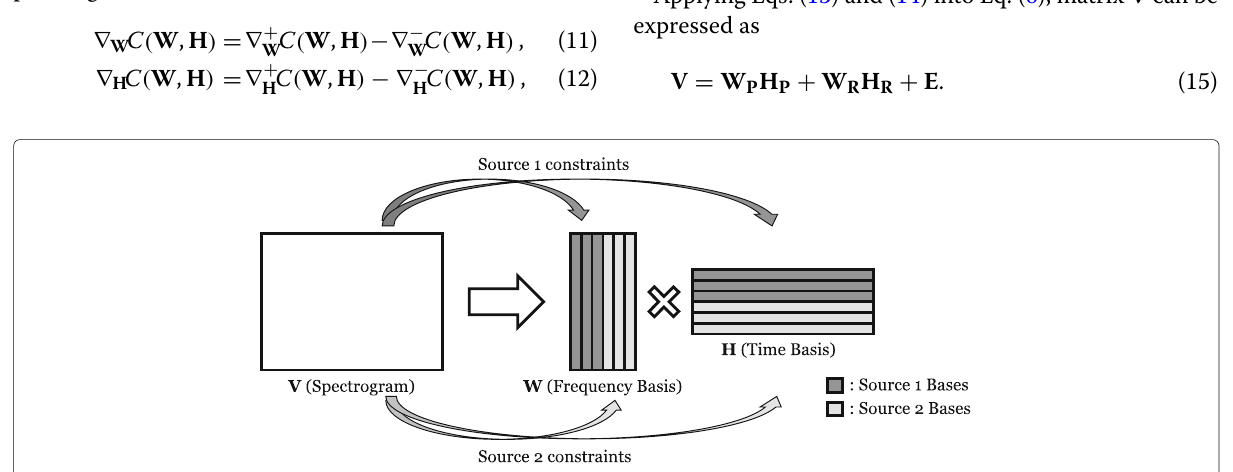
Fig. 4 NMF-based source separation. Each source group is extracted by applying different